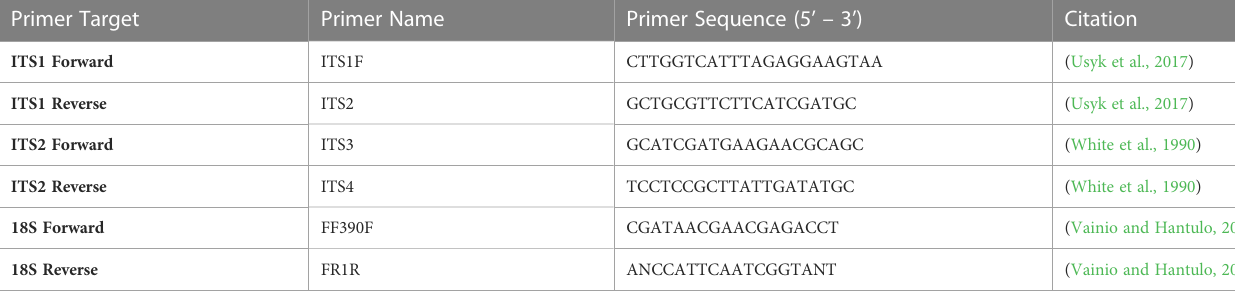
TABLE 1 Primers utilized in amplifying